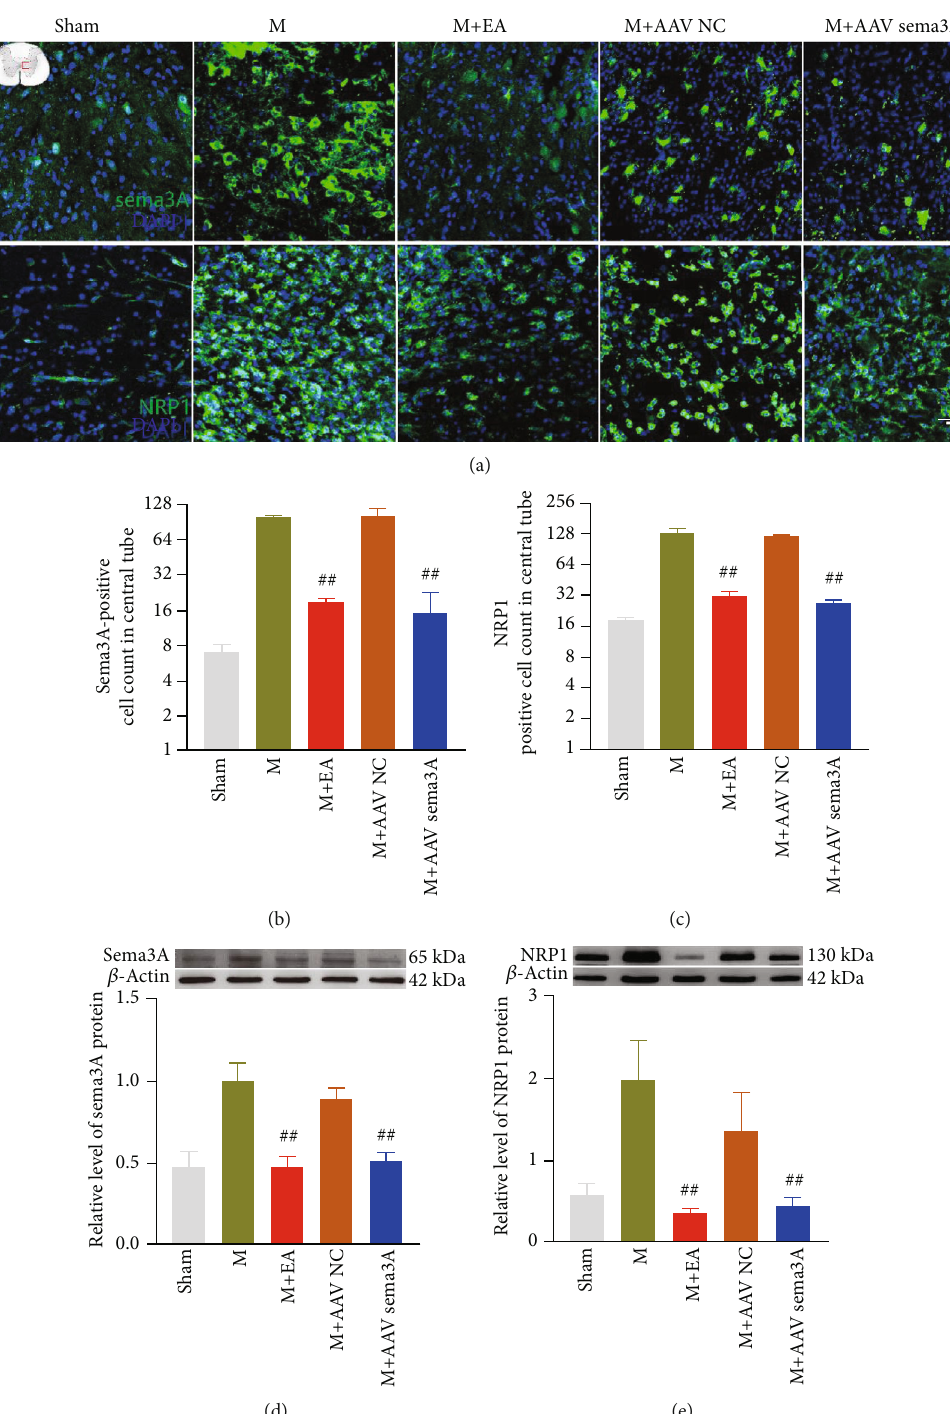
Figure 7: EA and Sema3A knockdown downregulated the expression of Sema3A and its receptor NRP1 around the central canal of the spinal cord. (a) A representative diagram of Sema3A and its receptor NRP1 expression around the central tube of gray matter in the spinal cord in the sham group, M +EA group, M +AAV Sema3A group, and M +AAV NC group was shown by immuno fl uorescence. (b, c) Quanti fi cation of the immuno fl uorescence data in panel (a), n = 3 . (d, e) The representative band and statistic of Sema3A and NRP1 in the spinal cord, n = 5 , compared with the SCI group, ## P < 0 : 01 . All data are presented as the mean ± SEM